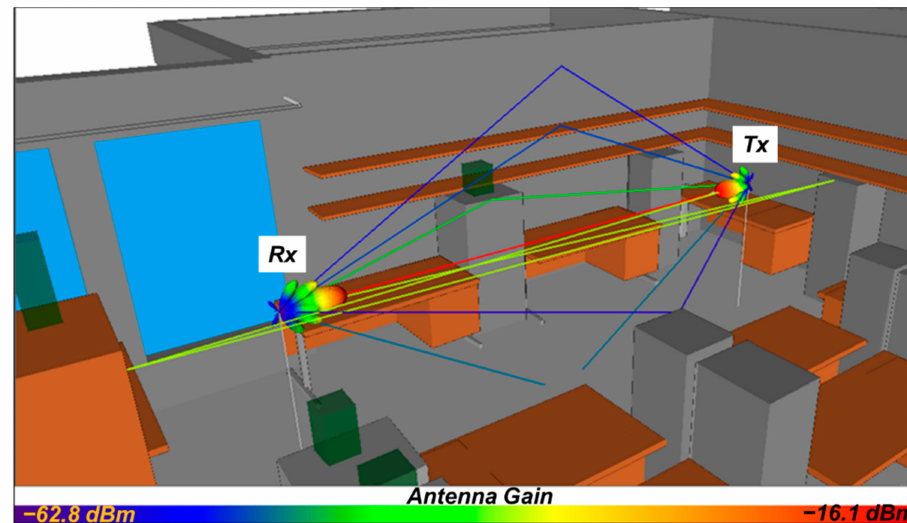
Figure 6. Strongest propagation paths for the LOS experiment.